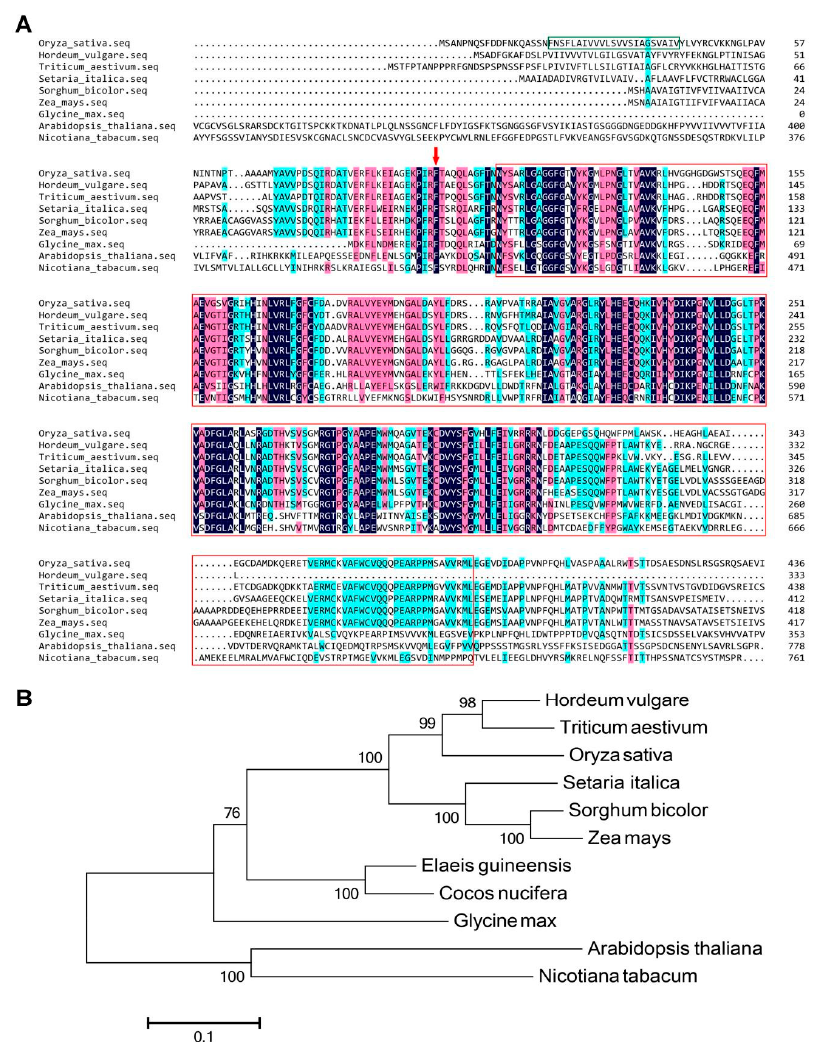
Figure 2. Sequence alignment and phylogenetic analysis of SPL26 homologues. ( A ) Partial sequence alignment of SPL26 homologues. The red arrow indicates the mutation site. The green box represents the transmembrane domain of OsSPL26. The red box represents the kinase domain of OsSPL26 and its homologues; ( B ) Phylogenetic tree of SPL26 proteins from 11 different species. The phylogenetic tree is constructed based on the neighbor-joining method using MEGA v6